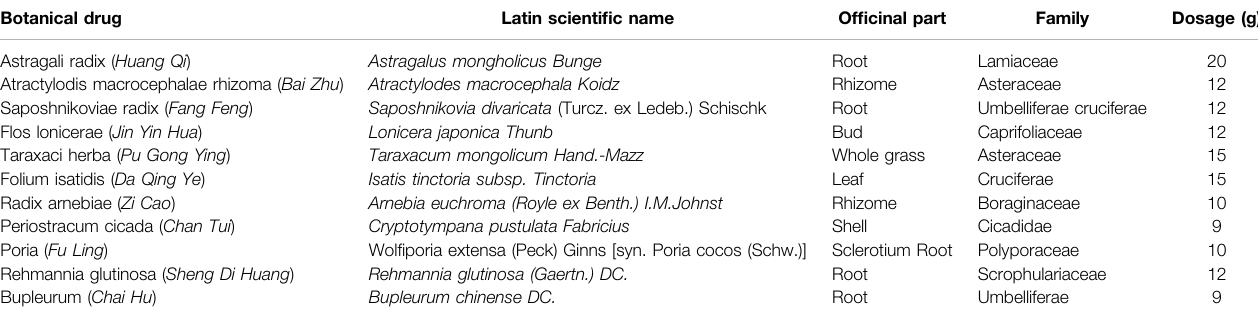
TABLE 1 | The composition of the YQJD formula. Botanical